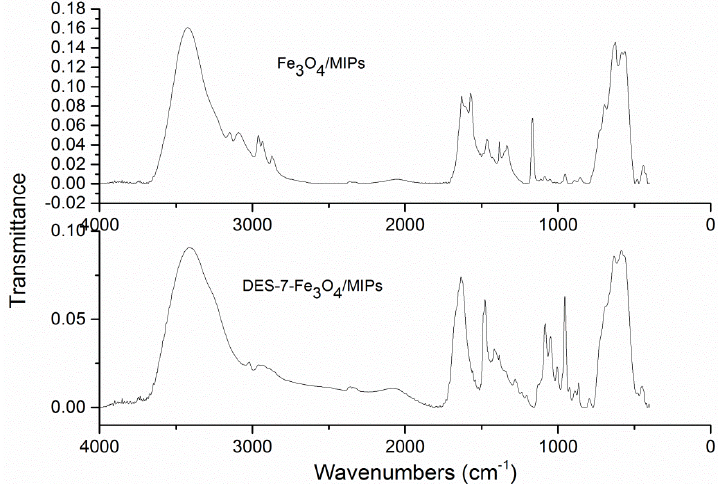
Figure 3. FT-IR images of Fe 3 O 4 /MIPs and DES-7-Fe 3 O 4 /MIPs.